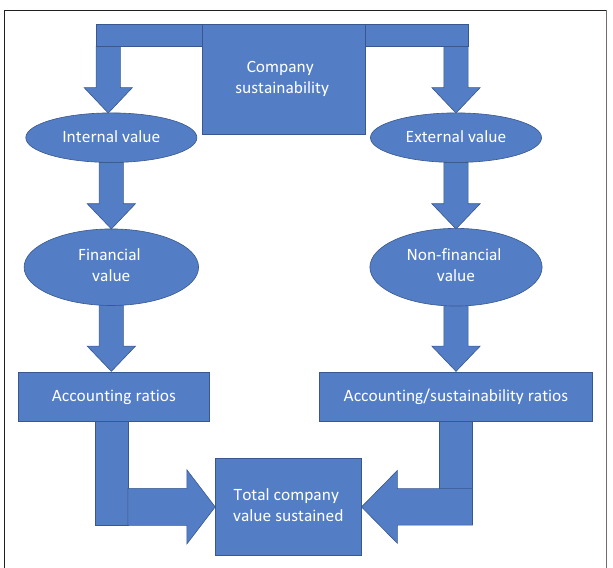
FIGURE 1: The relationship between accounting ratios and value sustainability.